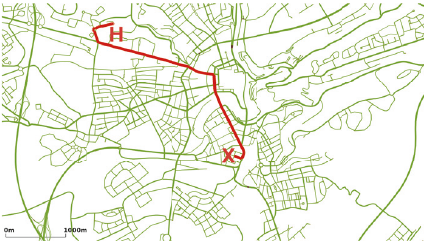
Figure 7: The Luxembourg scenario and the chosen route.